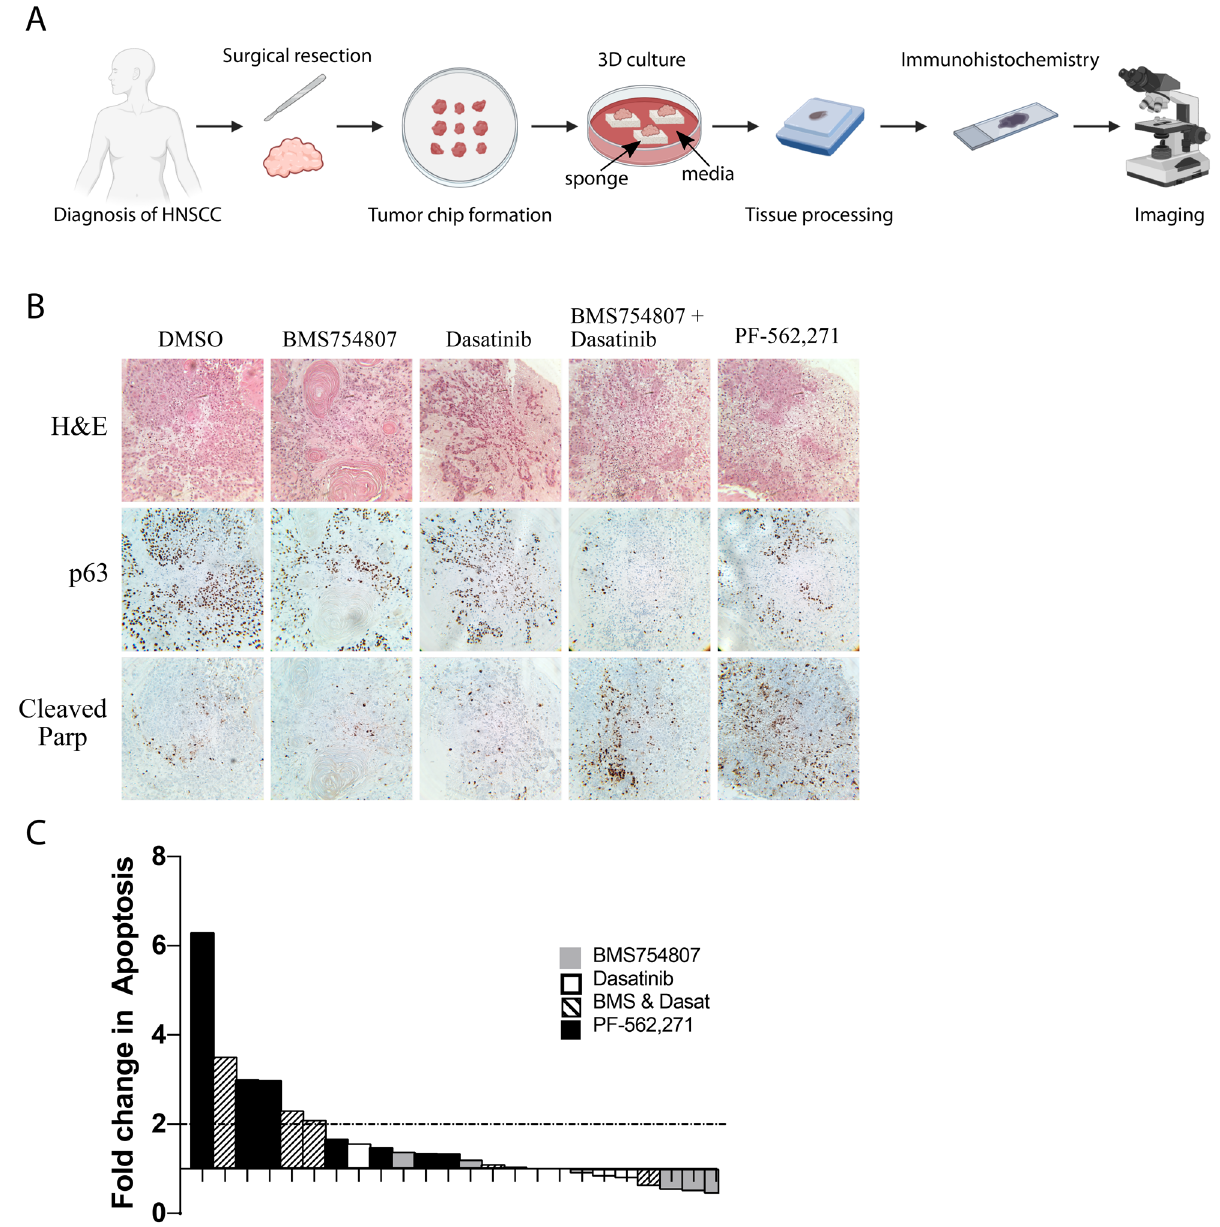
Figure 6. Treatment of ex vivo HNSCC tumor tissue with PF-562,271 or BMS754807 and dasatinib induces significant apoptosis. ( A ) Representation of the work-flow used to analyze human HNSCC tumor ex vivo tissue samples. The image was created with BioRender.com. ( B ) Representative histology images stained as indicated. ( C ) Graph represents the fold change in apoptosis as determined by cleaved-PARP staining in each of 6 ex vivo HNSCC tissue samples treated with either BMS754807, dasatinib, BMS754807 and dasatinib or